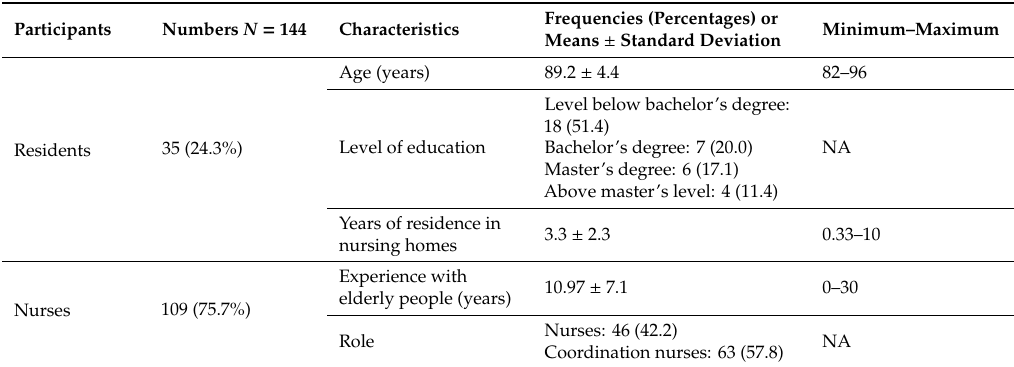
Table 1. Description of the study